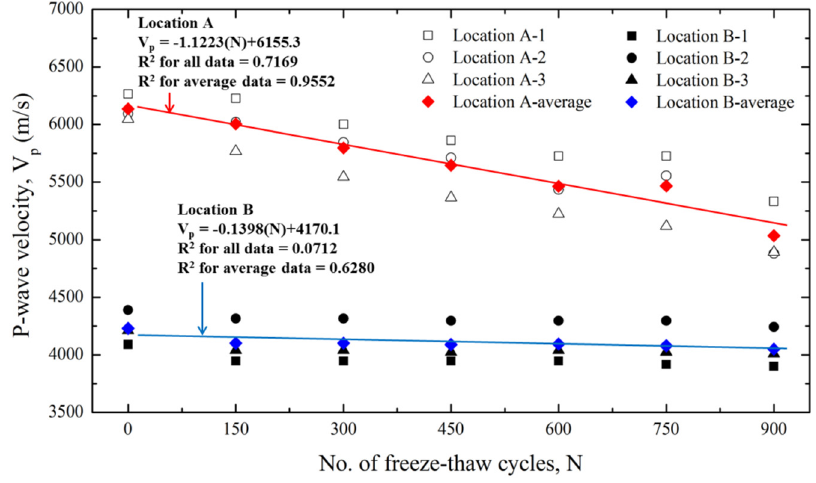
Figure 11. P-wave velocity changes with increasing freezing-thaw cycle of Locations A and B.